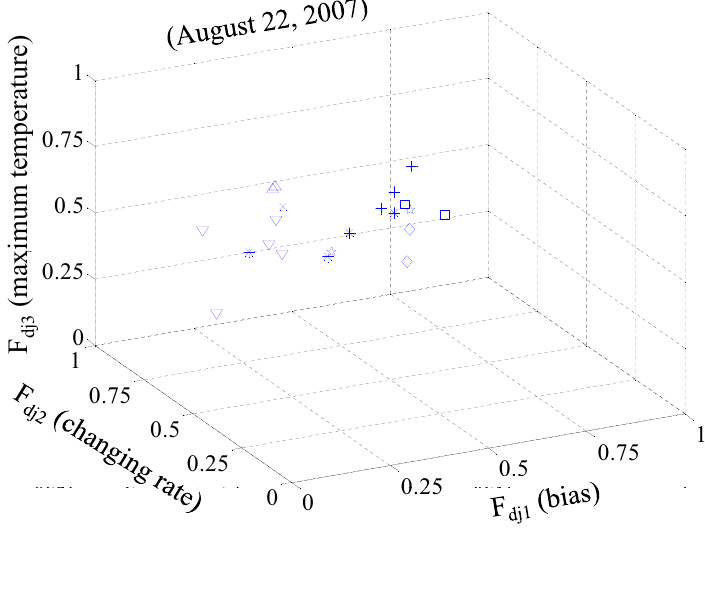
Figure 7. A plot of three features on a 3D-graph (August 22, 2007). Each symbol indicates the sensors being installed under the same environmental factors.